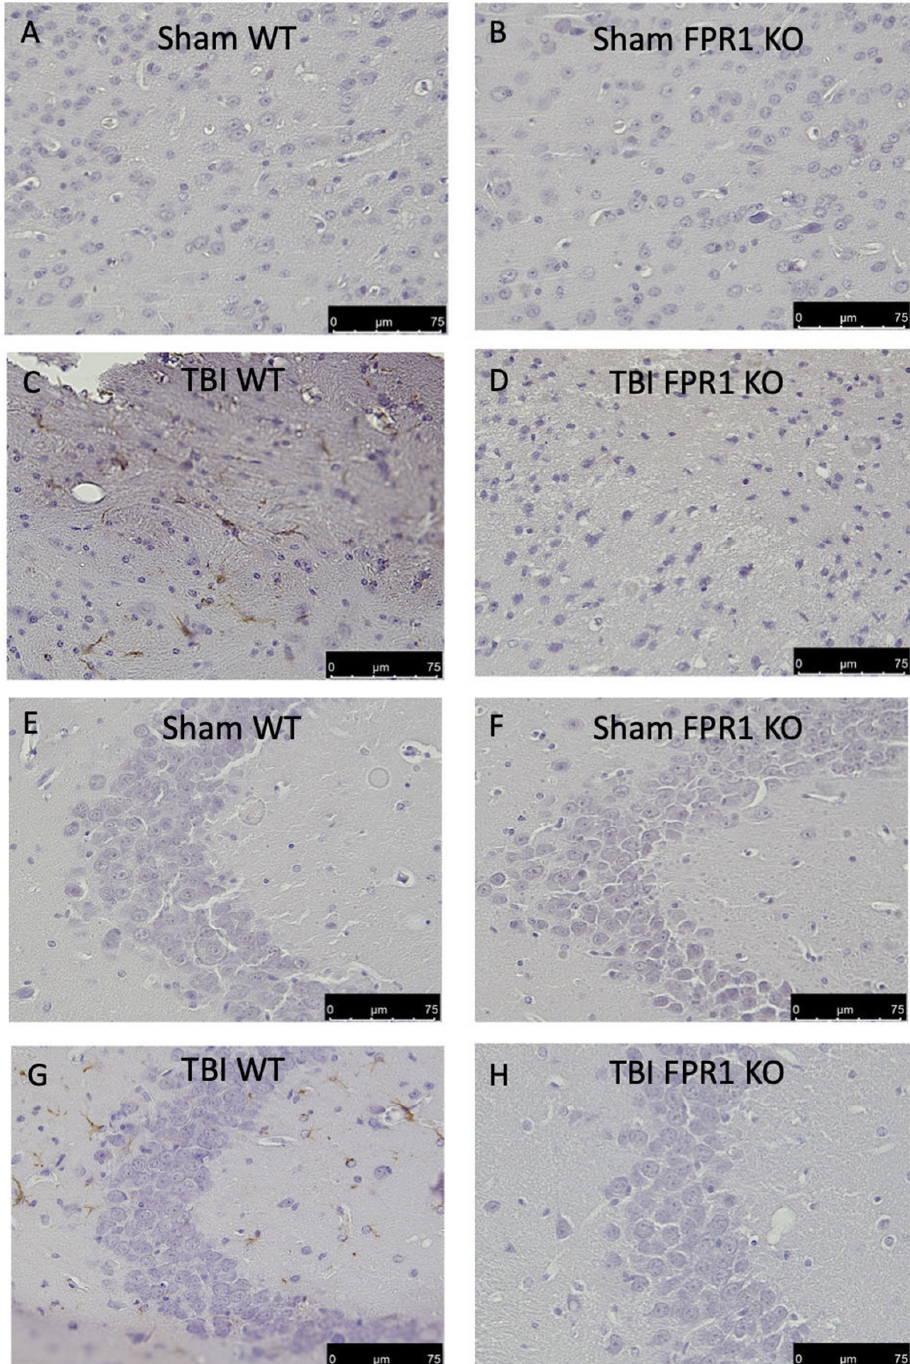
Figure 9. Effect of the absence of Fpr1 on microglia: Immunohistochemical analysis shows increased expression of Iba1 in TBI WT group cortex ( C ) and hippocampus ( G ), compared to the Sham WT cortex ( A ) and hippocampus ( E ) and Sham Fpr1 KO cortex ( B ) and hippocampus ( F ) Fpr1 KO animals 24 h after TBI show reduced expression of Iba1-positive cells in both the cortex ( D ) and hippocampus ( H ) For immunohistochemical staining, a 40× magnification is shown (75-μm scale bar). For the analyses, n = 5 animals from each group were employed. Results were analyzed by two-way ANOVA followed by a Bonferroni post-hoc test for multiple comparisons. Non-parametric data were analyzed with Fisher’s exact test. scale bar 75 m.